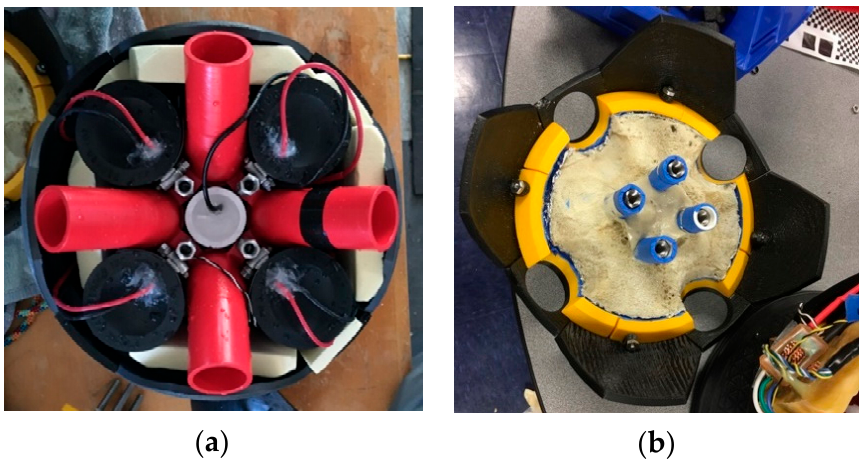
Figure 11. Buoyancy foam installation ( a ) Hard, closed cell foam pieces are inserted between the hull and battery tubes. Note the small water-tight cannister in the central cavity contained the power supply for the controller for use during testing. ( b ) Marine expanding foam under the top plate contributes to a high center-of-buoyancy.